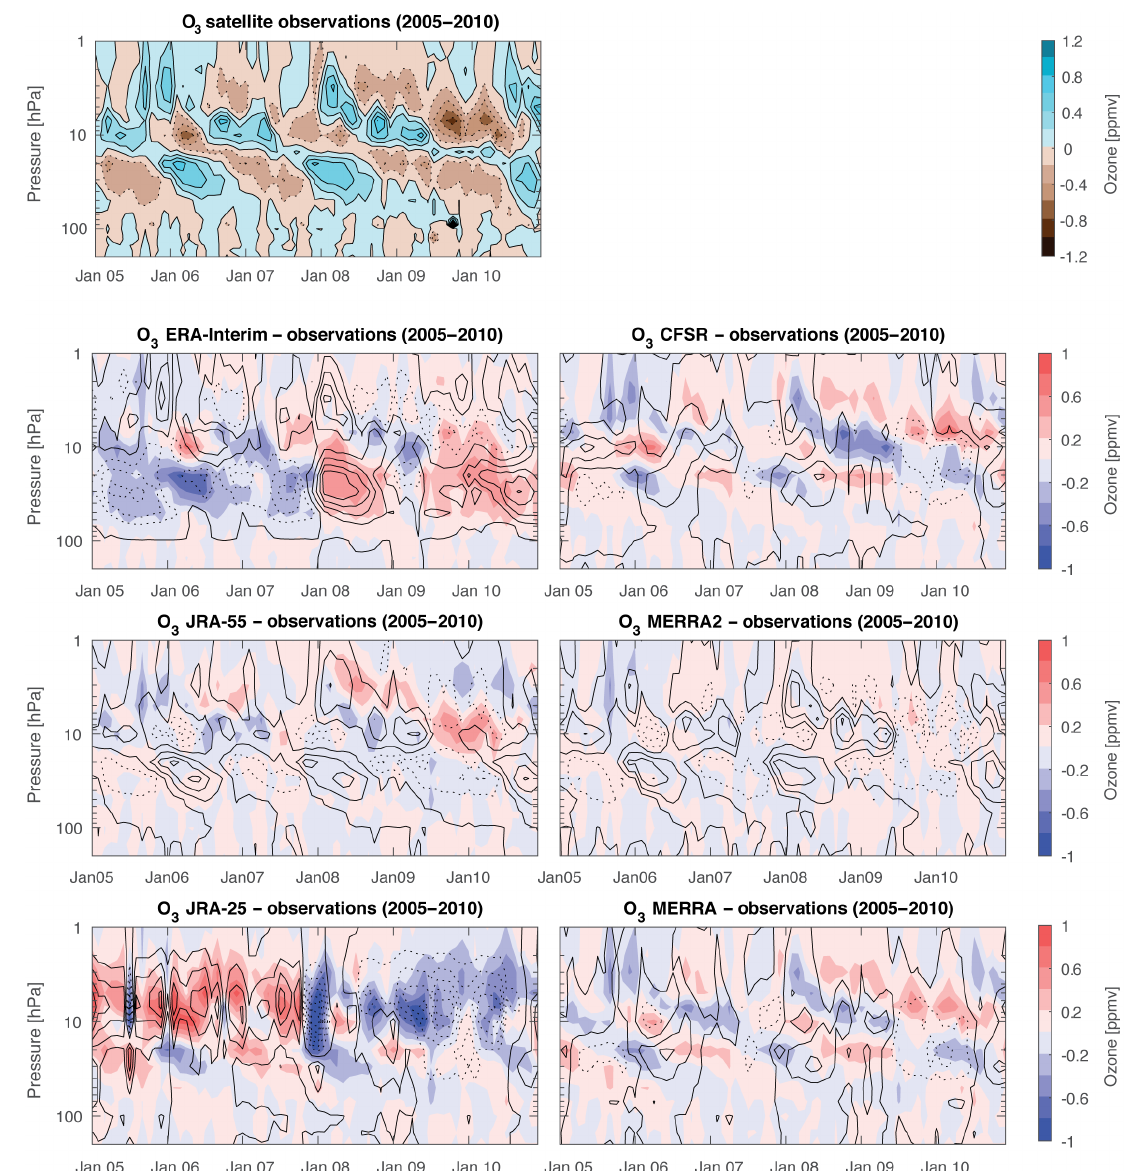
Figure 8. QBO ozone signal from the SPARC Data Initiative observations (upper left) during 2005–2010, defined as altitude–time cross sections of deseasonalized ozone anomalies averaged over the 10 ◦ S–10 ◦ N tropical band. Observations are based on three satellite data sets. The other panels show the differences in QBO ozone signals between each reanalysis and the observations ( R i − MIM, shaded contours), with the black line contours showing the QBO ozone signal generated by each corresponding